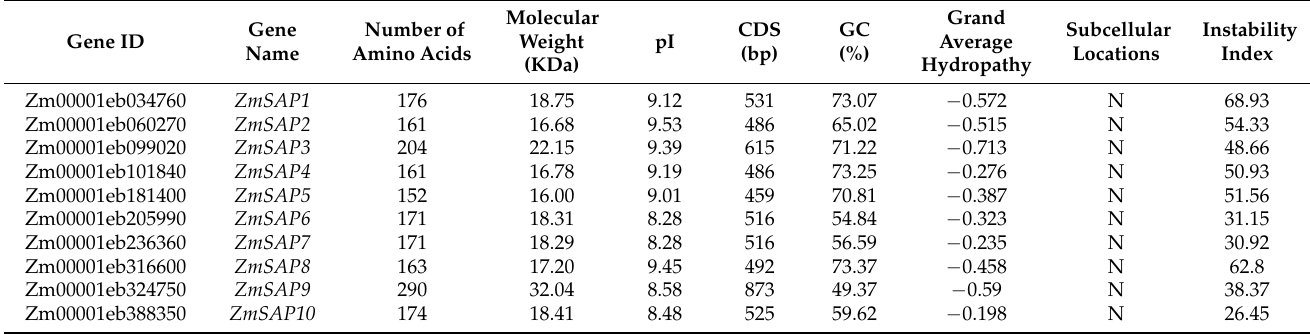
Table 1. Characteristics of ZmSAP genes in Zea mays.